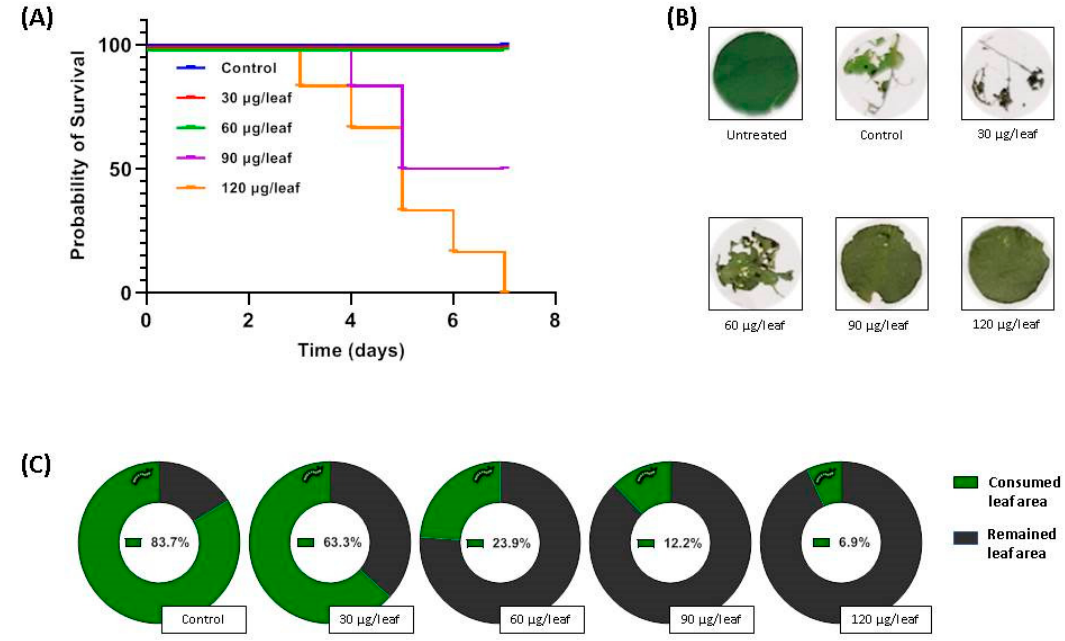
Figure 6. ( A ) Survival rate of Spodoptera littoralis larvae feeding on Ipomoea batatas (sweet potato) leaf discs painted with various concentrations of plumbagin ( n = 6). ( B ) Representative leaf discs at the end of the feeding period of day three. Leaf disks were renewed every day. ( C ) Leaf areas consumed by S. littoralis larvae (indicated in green) at day 3 depending on the applied plumbagin